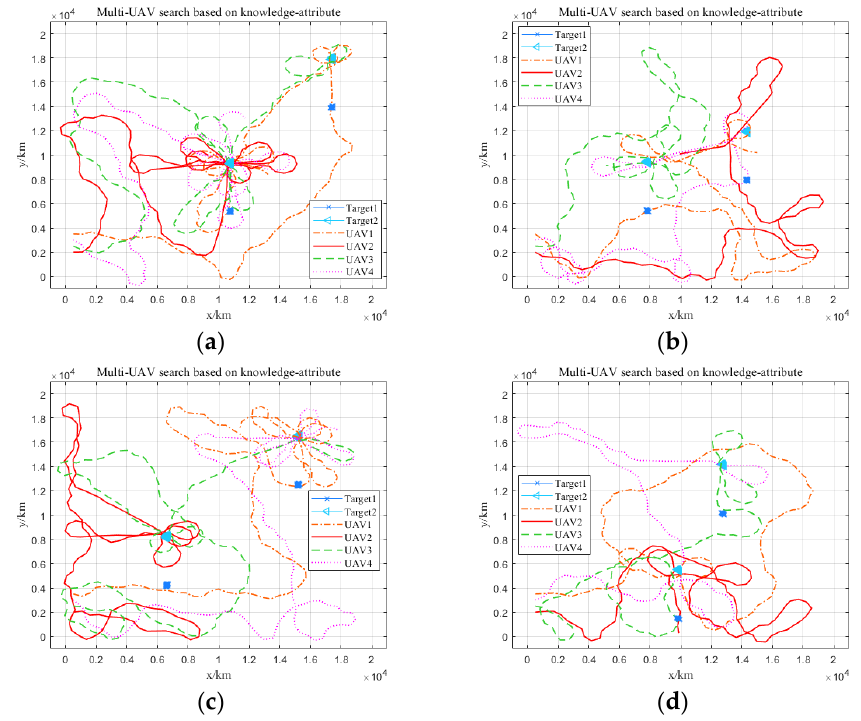
Figure 6. Search track of UAV in Scenario 2: ( a ) RI-MAC, ( b ) MAC, ( c ) ABC, ( d ) PSO.